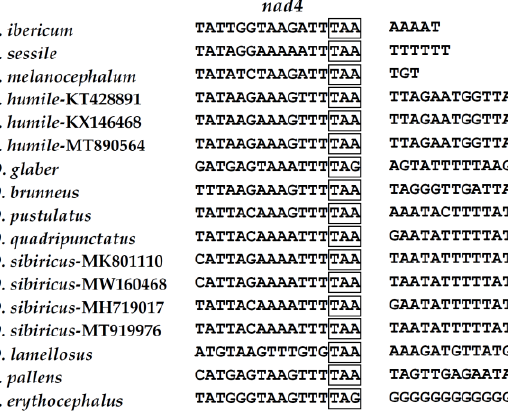
Figure 2. Sequences of the nad4 / nad4l junctions in Dolichoderinae species. In red are the 7 bp conserved regions that forms the overlap between nad4 and nad4l genes in other insect species. The stop codons of the nad4 gene are in boxes.